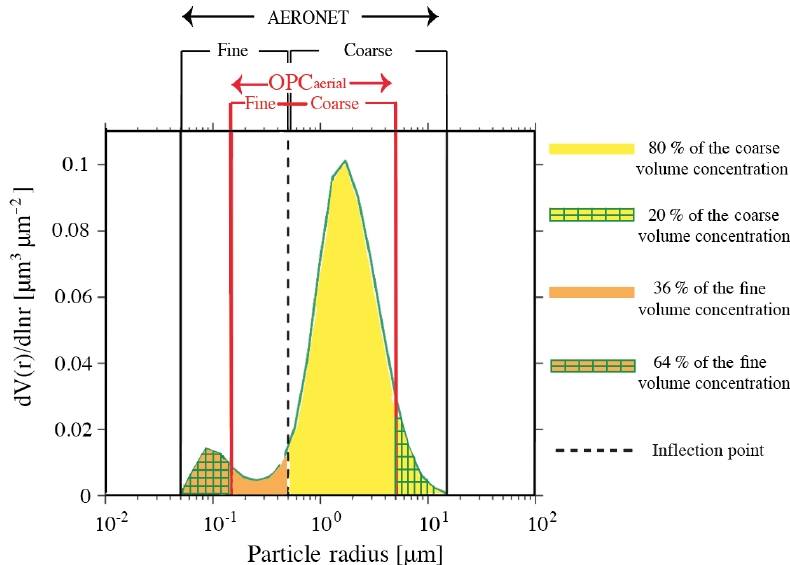
Figure 3. Column-integrated volume size distribution measured with the sun photometer over Nicosia at 06:57UTC on 15 April 2016. The ranges of particle sizes measured by AERONET sun photometers and by the OPC a are also indicated in the figure.